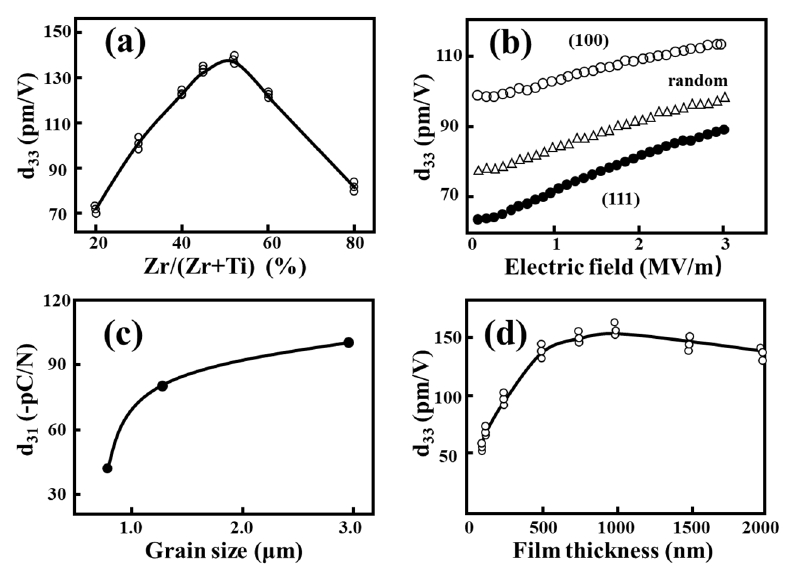
Figure 9. ( a ) Piezoelectric constant d 33 of PZT thin films according to the composition. Reprinted with permission from [73] Copyright 2013 Elsevier; ( b ) dependence of orientation on d 33 under different electric field. Reprinted with permission from [75] Copyright 2000 AIP Publishing; ( c ) relationships between grain size and piezoelectric constant d 31 . Reprinted with permission from [76]